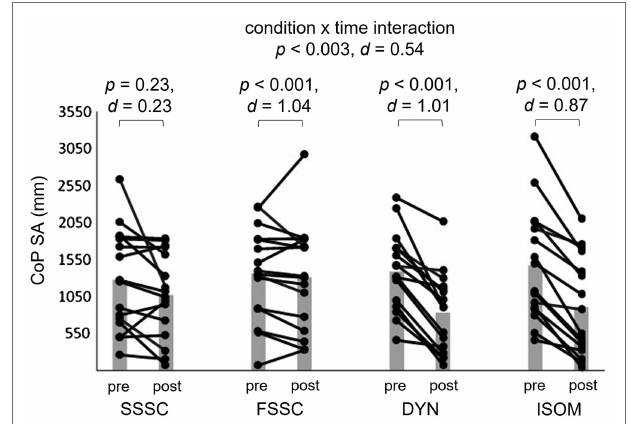
FIGURE 2 | Mean value (grey bar) and individual scores of the center of pressure surface area pre- and post-intervention. DYN, dynamic strength exercise; ISOM, isometric strength exercise; SSSC, slow stretch-shortening cycle exercise; FSSC, fast stretch-shortening cycle exercise; CoP SA, center of pressure surface area; d, Cohen’s